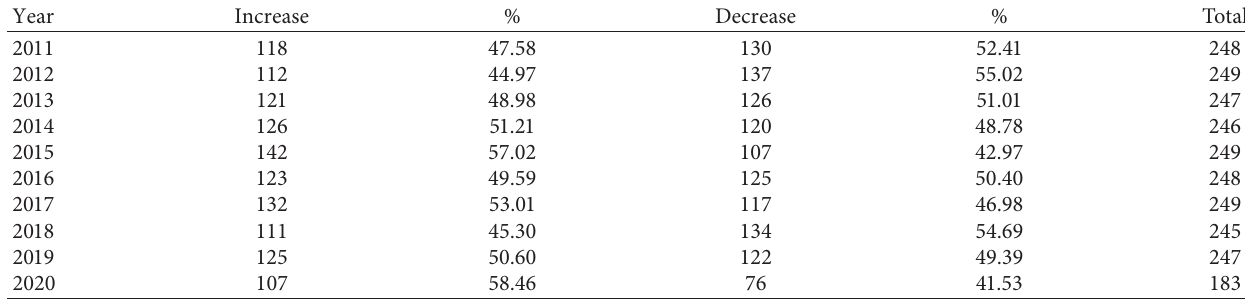
Table 9: Percentage of increase and decrease cases of SZSE